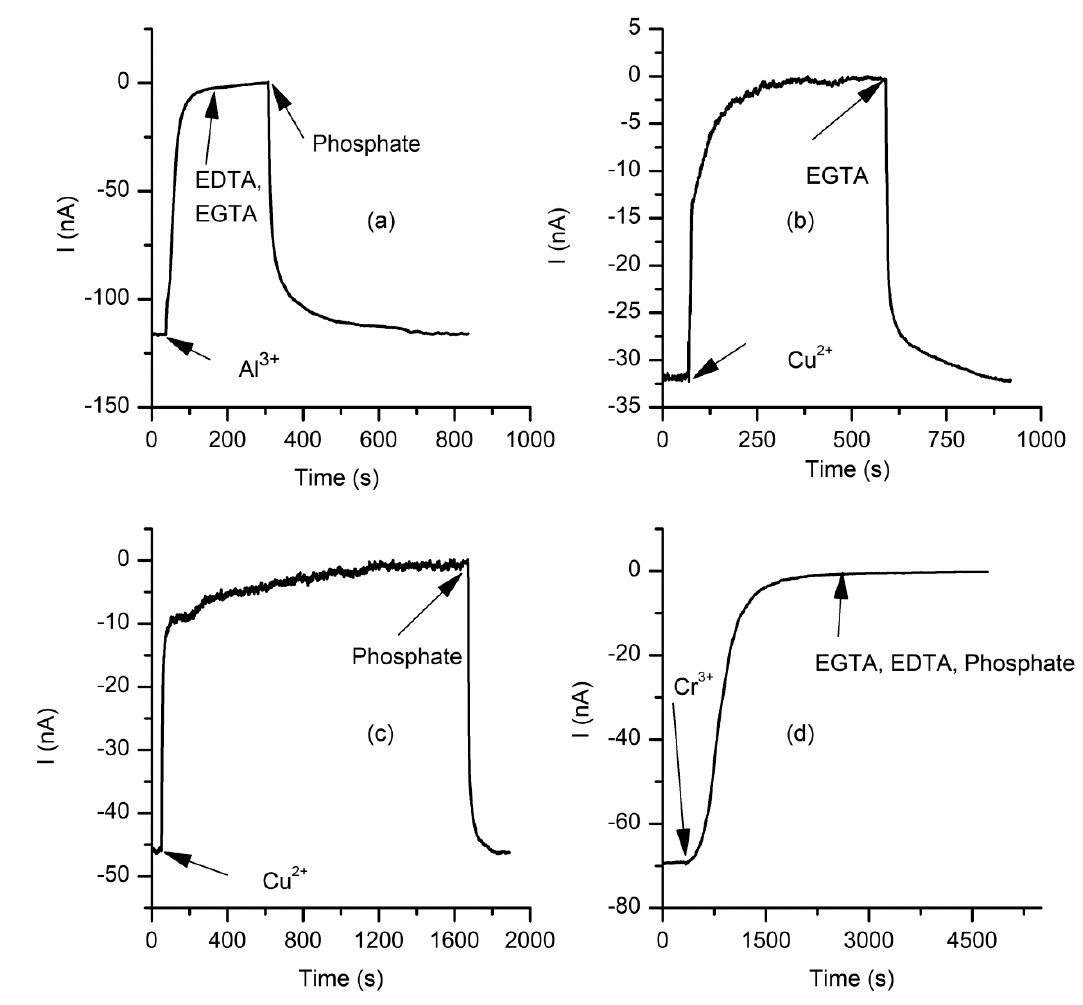
Figure 4. Most, but not all, multivalent metals reversibly interact with lysenin channels. ( a ) Al 3+ precipitation by phosphate addition reinstates the initial macroscopic conductance. Cu 2+ removal by EGTA ( b ) or phosphate precipitation ( c ) quickly restores the ionic conductance; ( d ) EDTA, EGTA, or phosphate addition does not cancel the inhibitory effects of Cr 3+ . Adapted from [61], with